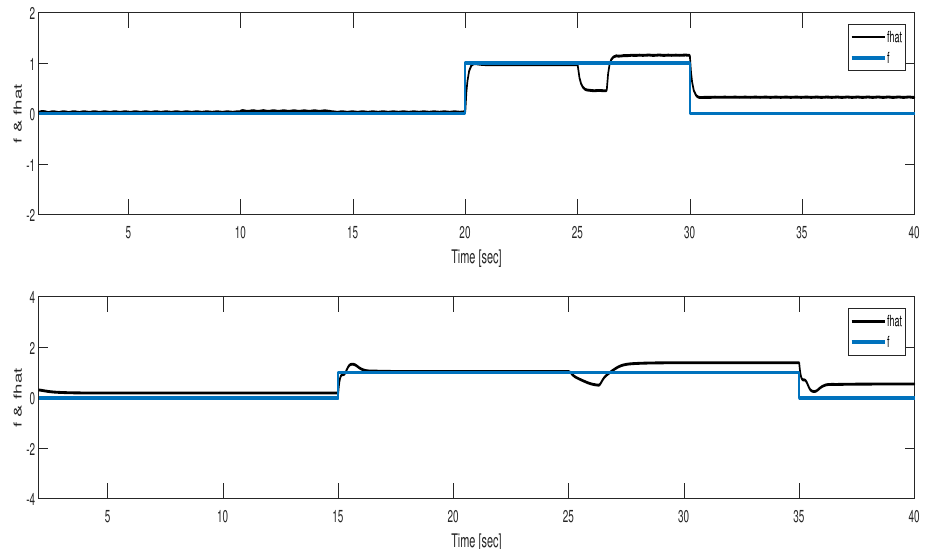
Figure 7. The simultaneous actuator and sensor fault reconstruction using the approach presented in